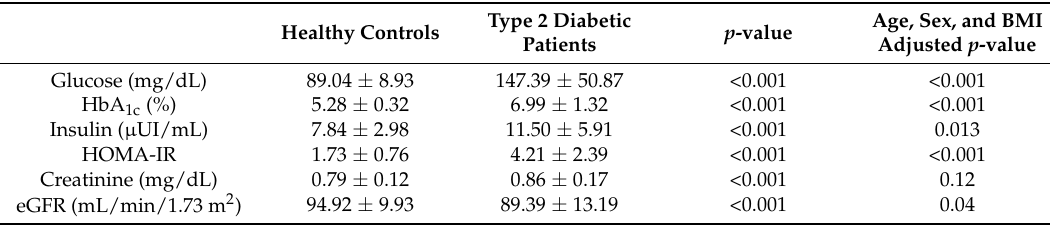
Table A1. Differences in glycaemic control and renal function between controls and type 2 diabetic